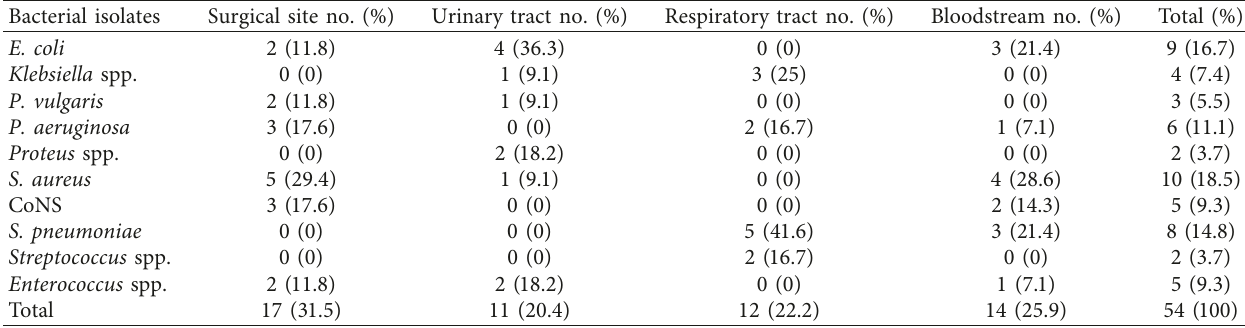
Table 3: Antimicrobial susceptibility pattern of Gram-positive bacteria isolated from NI-suspected patients at Hiwot Fana Specialized University Hospital, Eastern Ethiopia, March 2017 to July 2017. Bacterial species Total isolates Pattern